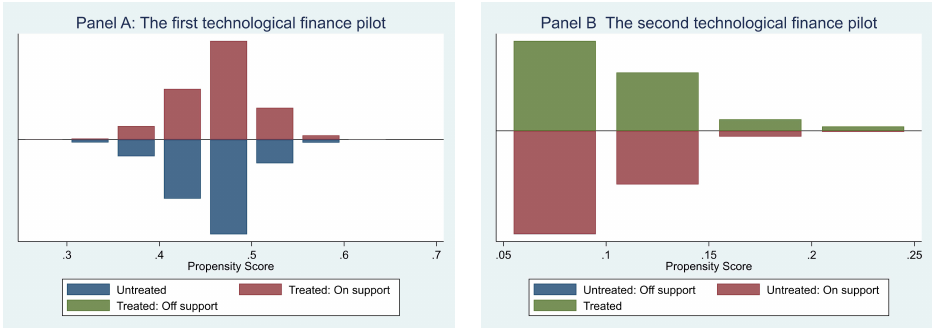
Fig. 2 The common value range of the propensity scores of the enterprises in the experimental group and control group of